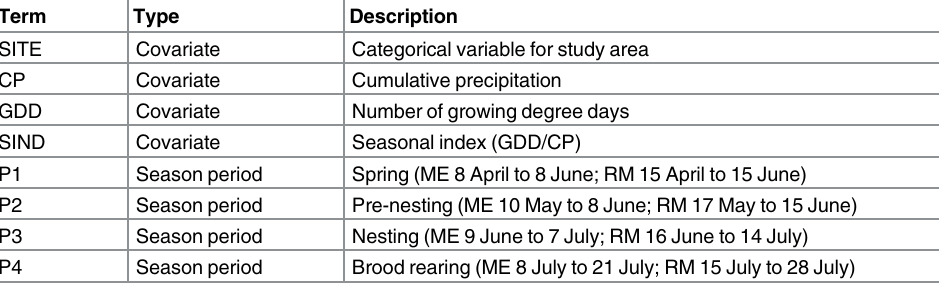
Table 1. Terms used for response variables, covariates, and periods over which weather data were measured. A description for each term is provided. Covariates are presented in the model results with a pre- fix for the specific period they represent. Study sites were at Mt. Evans (ME) and Trail Ridge at Rocky Moun- tain National Park (RM) in